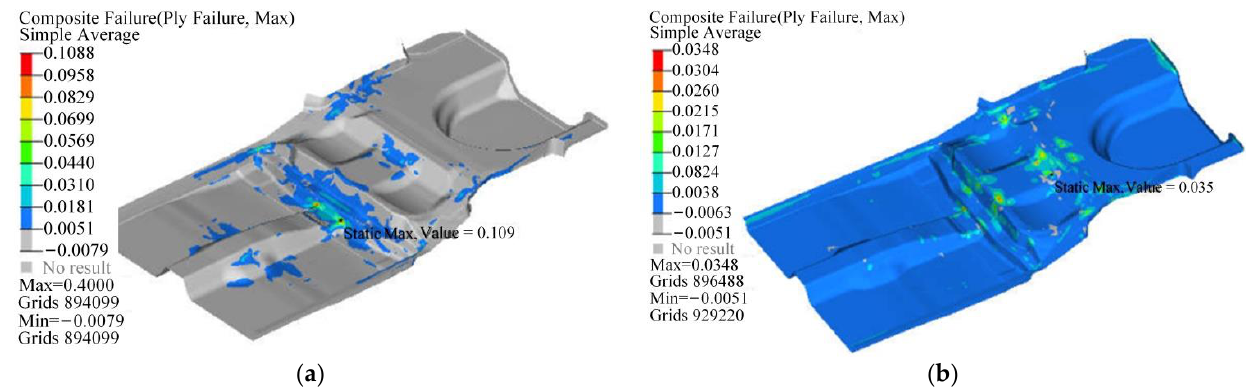
Figure 22. Distribution of failure index of composite floor: ( a ) Bending condition; ( b ) Torsional condition.